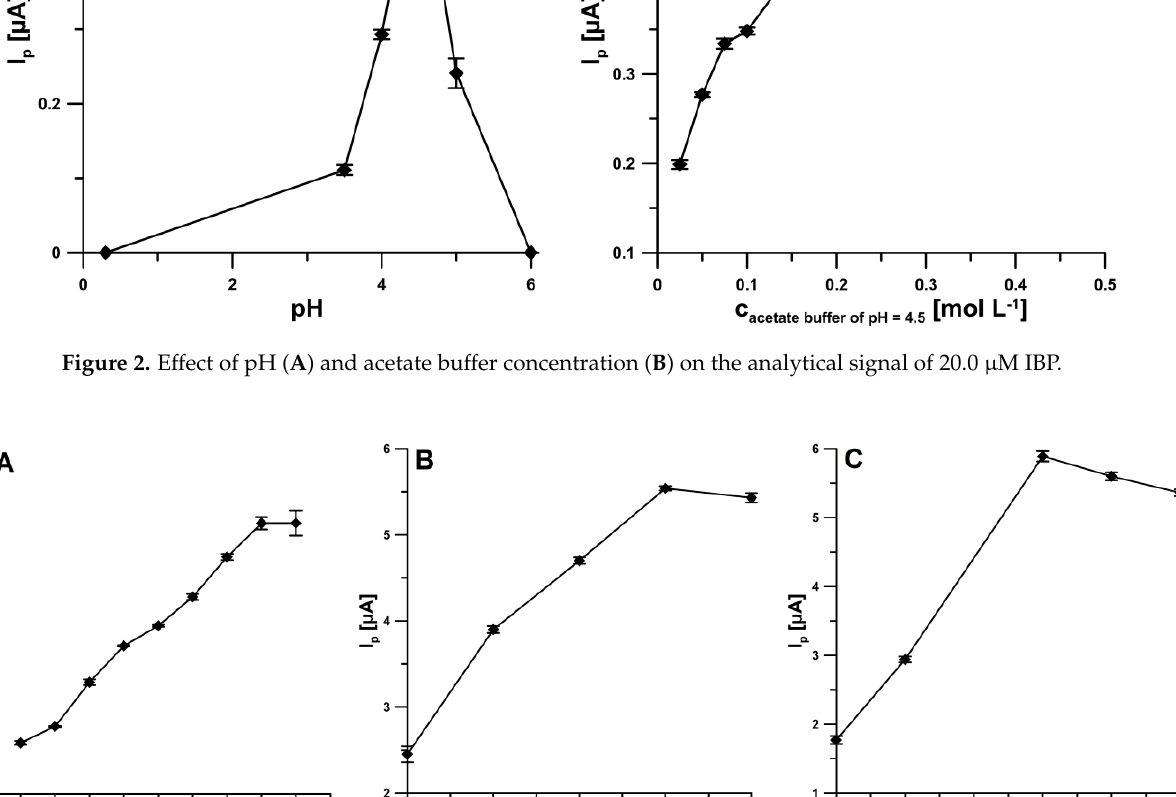
Figure 2. Effect of pH ( A ) and acetate buffer concentration ( B ) on the analytical signal of 20.0 µM IBP.